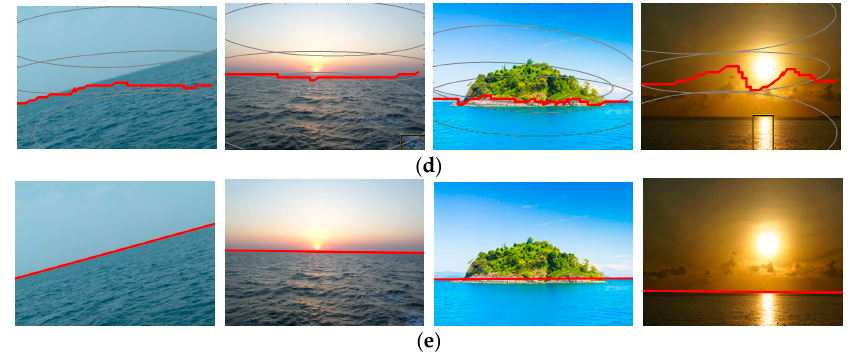
Figure 10. A comparison of various horizon line detection methods using the authors’ testing data: ( a ) Original image; ( b ) Wang’s algorithm; ( c ) MSCM-LiFe; ( d ) SSM; ( e ) CFS method.